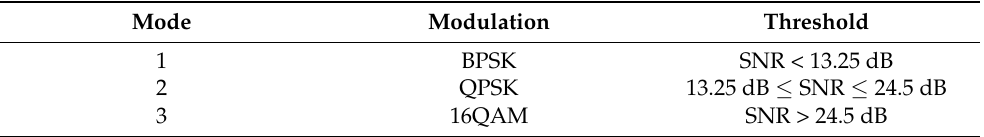
Table 4. Parameters used in the cluster-based adaptive modulation during the river experiment.